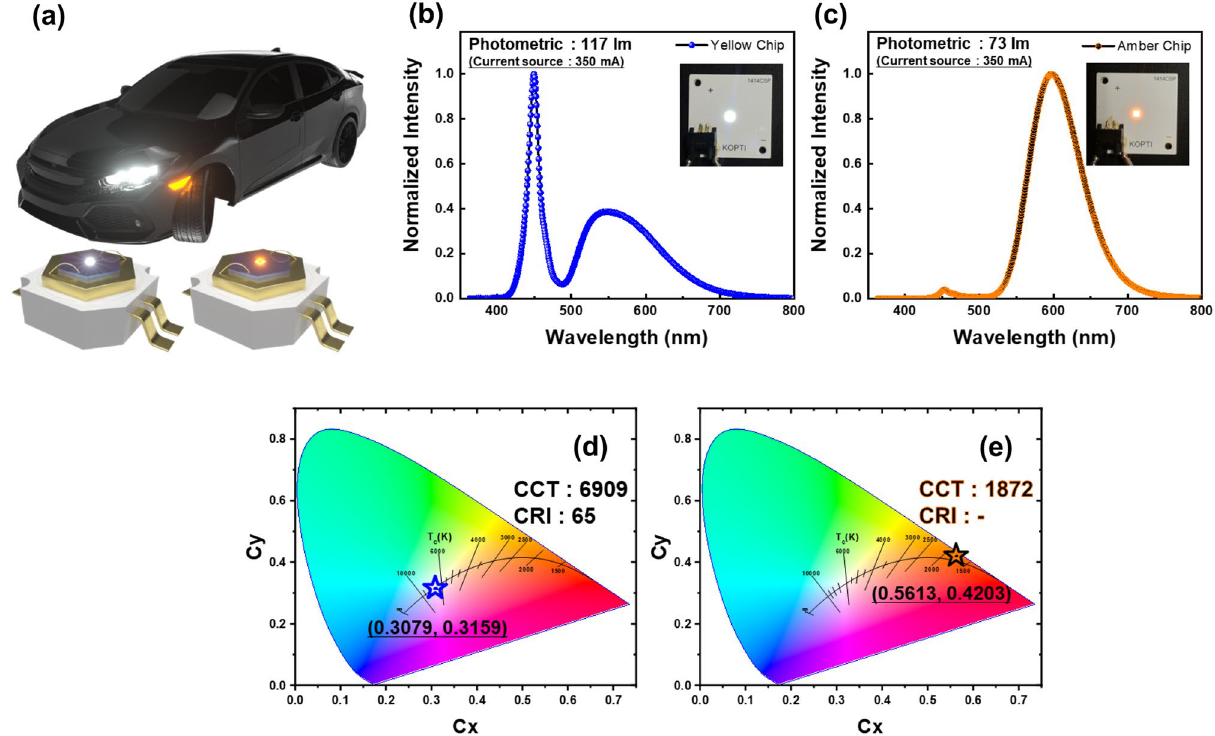
Figure 9. ( a ) Application example of fabricated PiGs ( b ), ( d ) Package test result of Yellow PiG ( c ), ( e ) Package test result of Amber